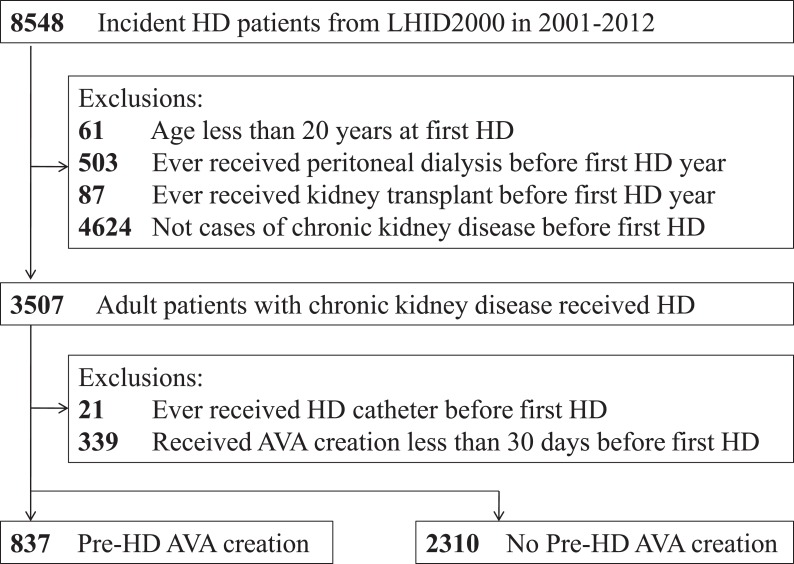
Overall flow diagram of the research design and sampling strategy.AVA, arteriovenous access; HD, hemodialysis; LHID2000, Longitudinal Health Insurance Database 2000, a validated subset extracted from the Taiwan National Health Insurance Research Database.